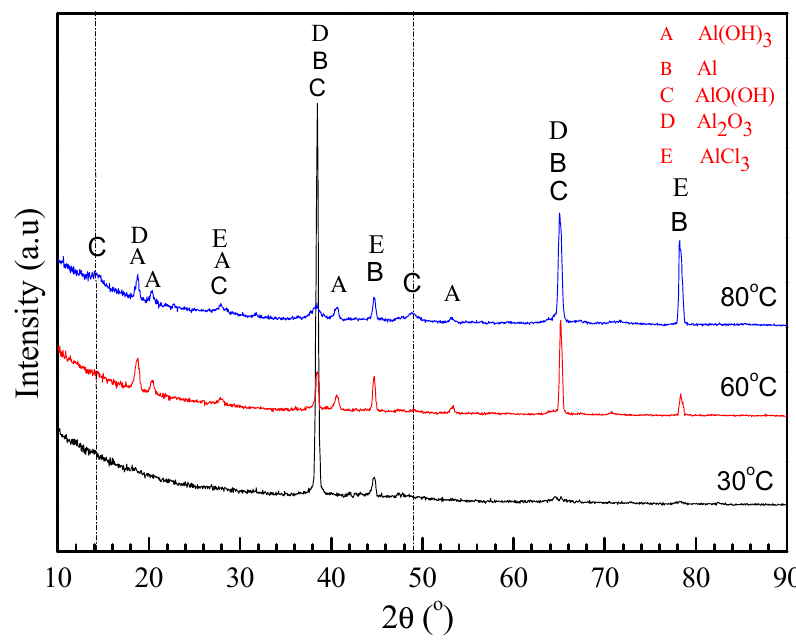
Figure 15. XRD patterns of the inner corrosion products formed on the surface of 2A02 Al alloy after exposure at different temperatures for 200 h.